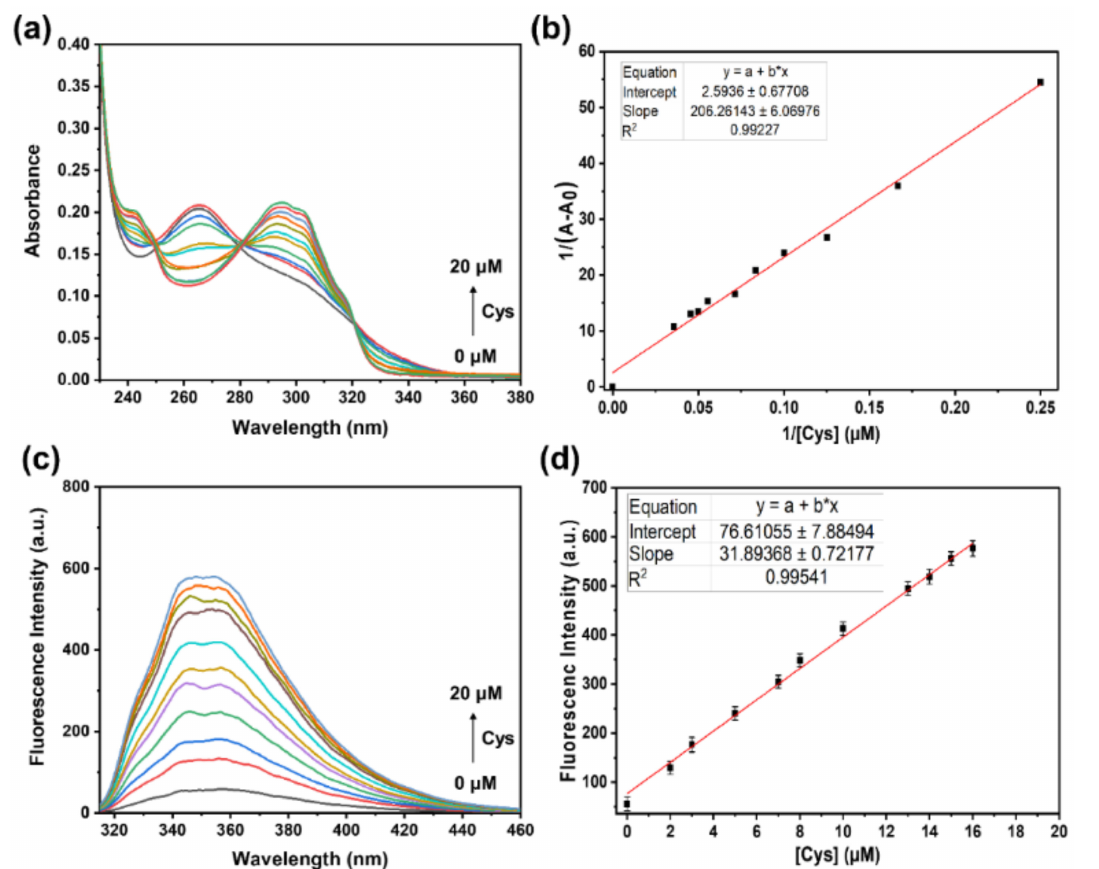
Figure 7. Changes in ( a ) UV–vis absorption spectra and ( c ) fluorescence spectra ( λ ex = 303 nm, λ em = 350 nm) and respective calibration curves ( b ) and ( d ) for titration of A-B (10 µ M) with Cys (0–20 µ M) in 1 mM HEPES buffer at room